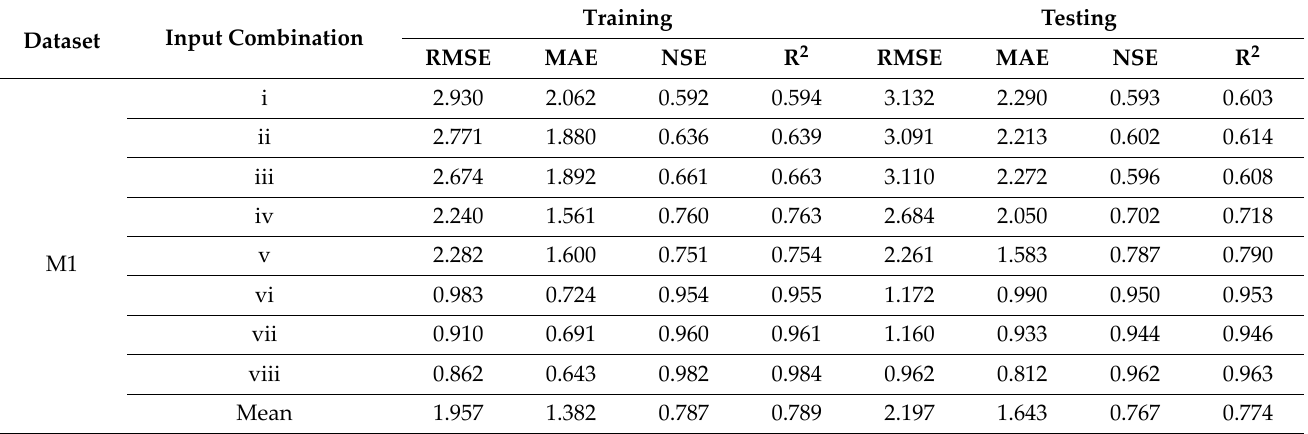
Table 6. The results of the model RVFL‑WCAMFO for monthly time